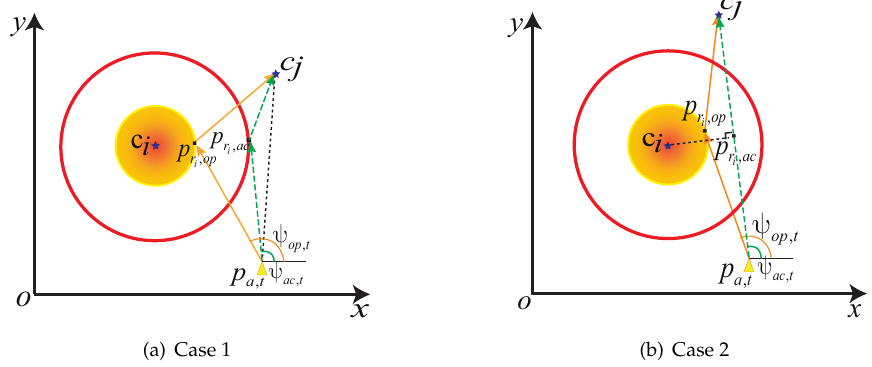
Figure 2. The AUV multi-modal steering angle diagram. (a) The trajectory of the AUV from the current coordinates p a , t towards the next target c j will not sail through the communication region C m of c i . (b) The trajectory of the AUV from the current coordinates p a , t towards the next target c j will sail through the communication region C m